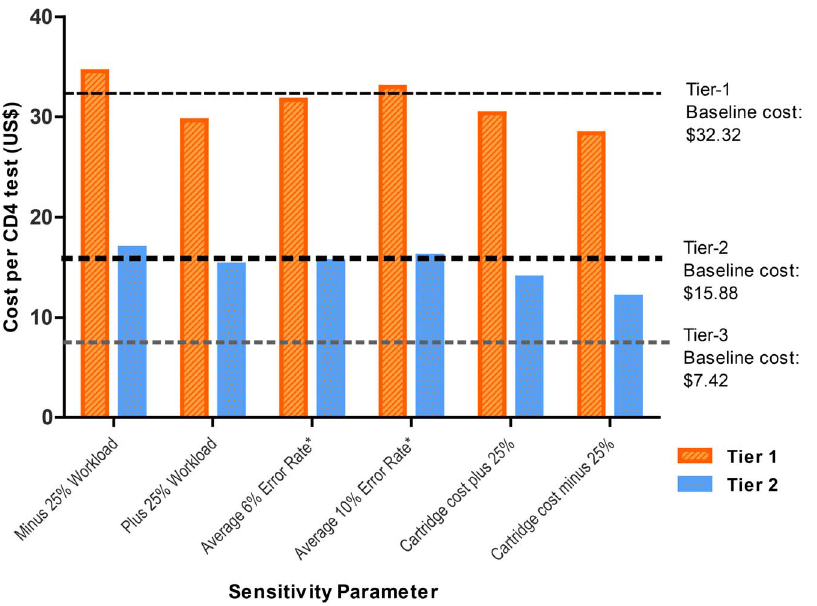
Fig. 3. Sensitivity analysis. Sensitivity analysis for POC tiers indicating the impact of test volume, error rates and cartridge costs on cost-per-result. (High error rates of 10 and 15% for Tiers 2 and 1 respectively and low error rates of 6 and 9% per POC tier were used). Baseline cost for Tier-1 (upper dotted line), Tier-2 (lower dotted line) and Tier-3 (feint dotted line) is displayed for reference. This analysis confirms that POC cost is dependent upon volume of samples across a national programme and individual cost of cartridges.